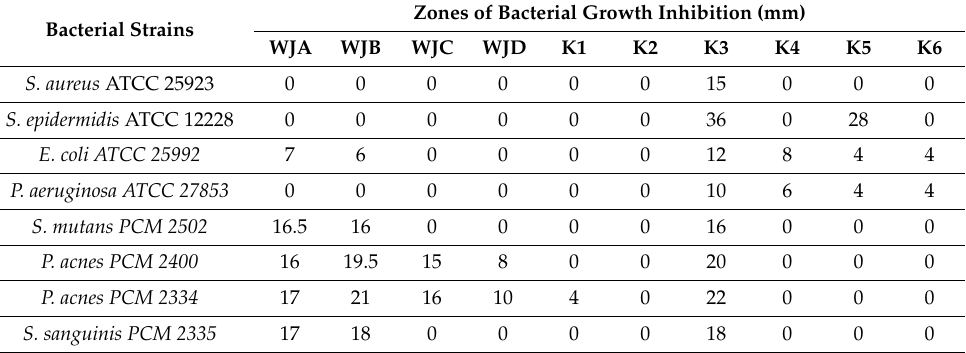
Table 5. Zones of bacterial growth inhibition expressing the antibacterial activity of the E. japonicum extracts. Extracts from the flowers (WJA), roots (WJB), and leaves (annual—WJC and biennial—WJD) of E. japonicum . K1—quercetin; K2—luteolin; K3—gallic acid; K4— p -coumaric acid; K5—caffeic acid; K6—vanillic